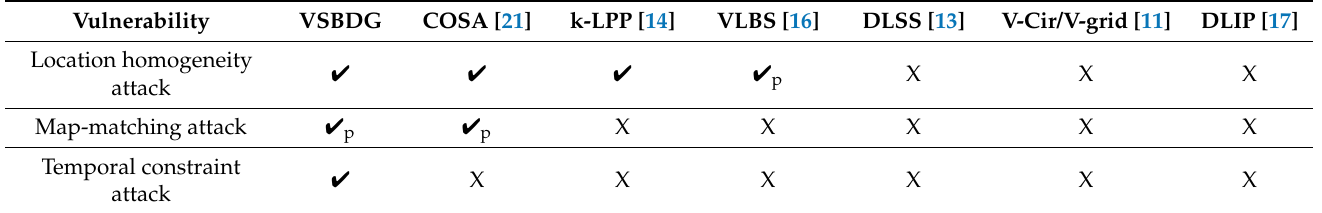
Table 6. A comparison of the proposed (VSB) and the existing dummy approaches based on how various vulnerabilities are addressed.